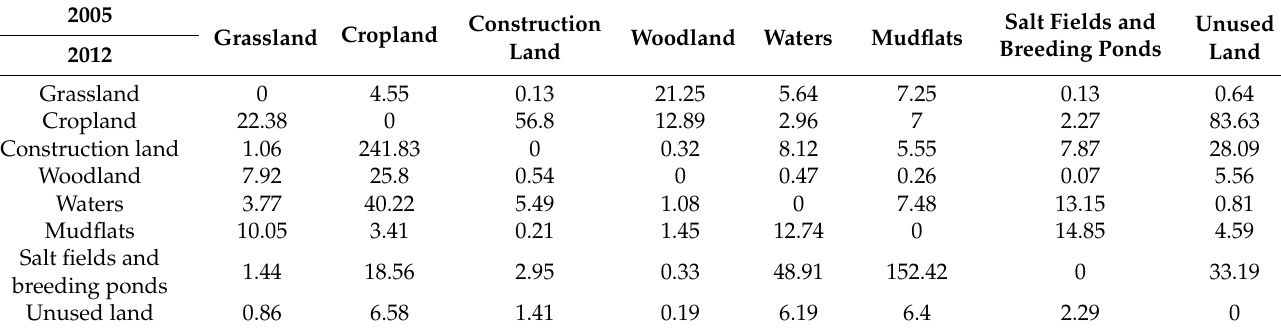
Table 3. The Yellow River Delta landscape type transfer matrix